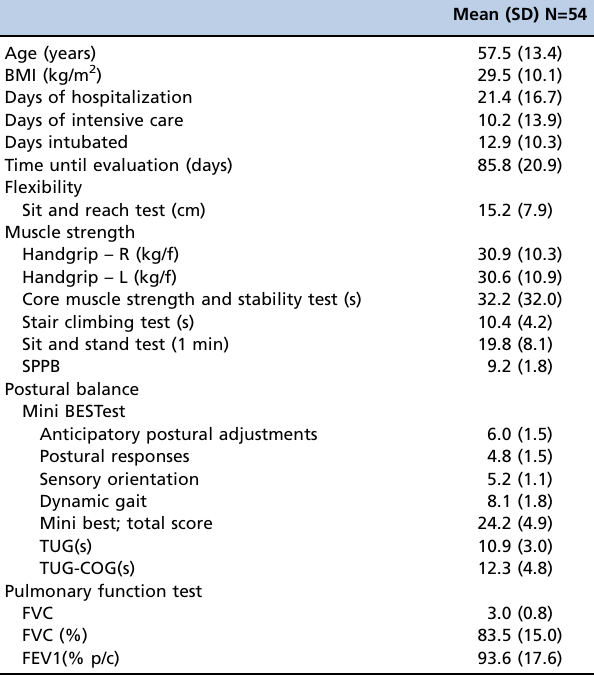
Table 1 - Characterization of coronavirus disease survivors.